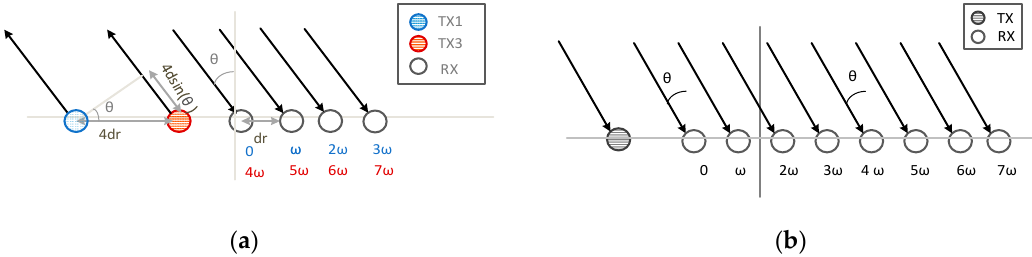
Figure 3. The generation of virtual array: ( a ) MIMO radar with two transmit antennas and four receive antennas. ( b ) Virtual array of eight receive antennas.